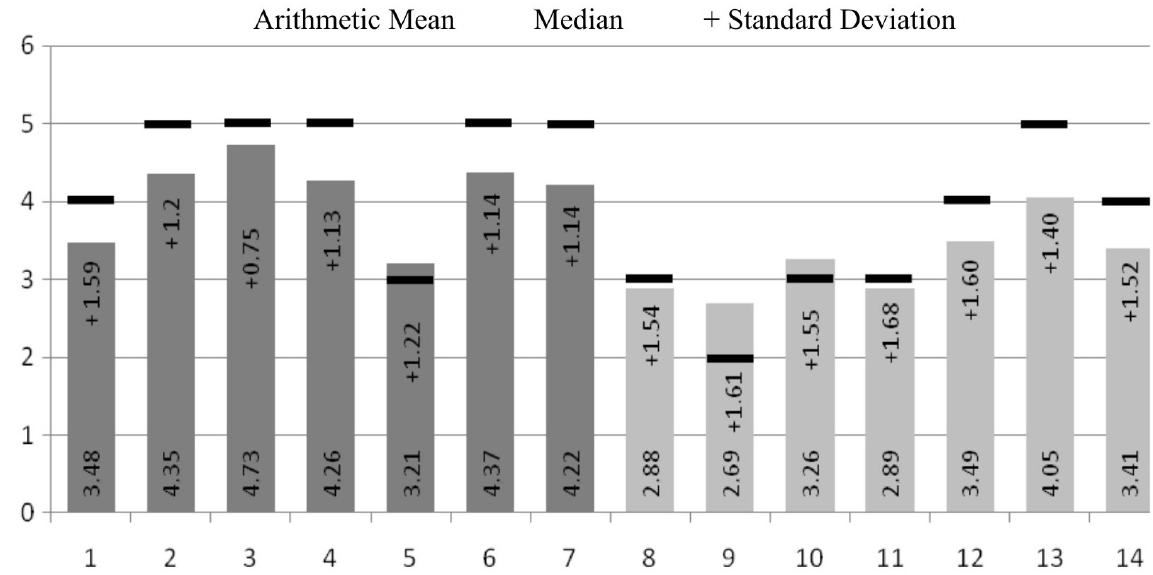
FIGURE 3 – Distribution of arithmetic mean, median and standard deviation of statements presented to antibiotic